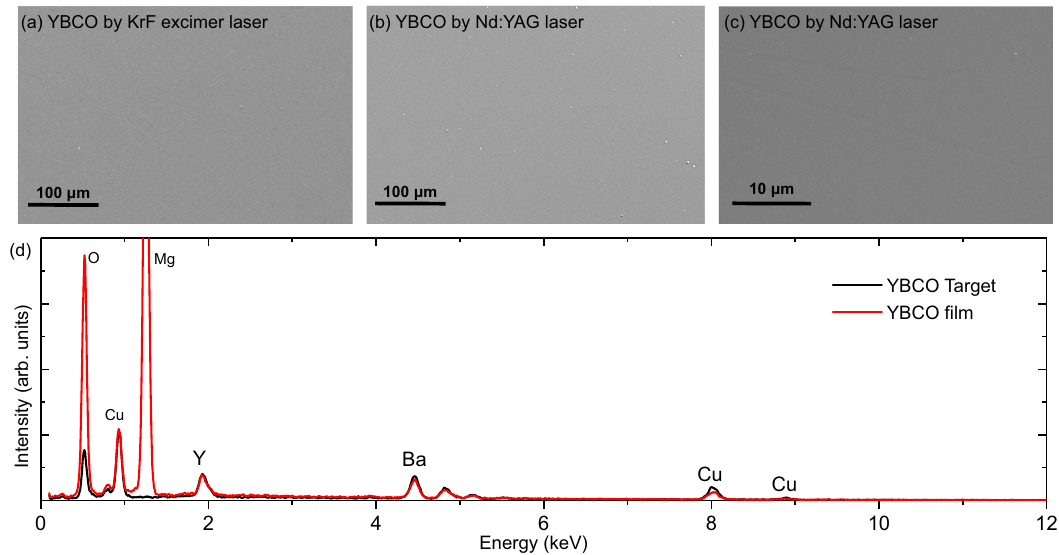
Figure 3. SEM images of the YBCO thin films grown using ( a ) KrF Excimer laser and ( b and c ) first harmonic Nd: YAG solid-state laser are presented. ( d ) Comparison of the EDS spectra of a YBCO target (black) and a YBCO film (red) grown by the first harmonic Nd: YAG laser.